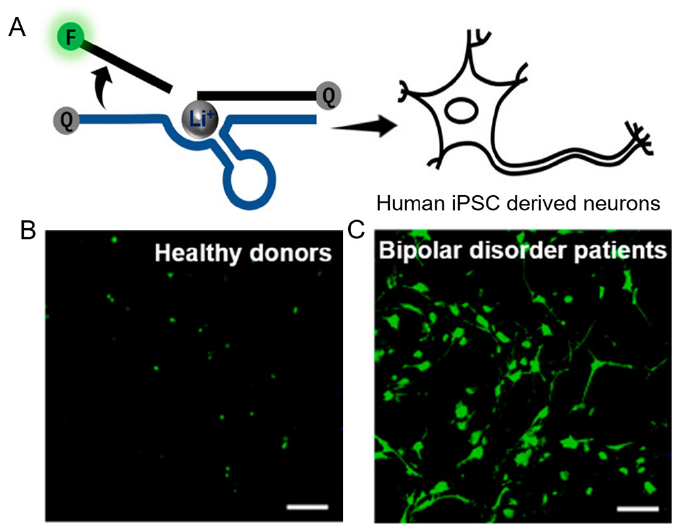
Figure 8. ( A ) Design of the Li + DNAzyme catalytic beacon. Intracellular Li + imaging in neural progenitor cells of ( B ) healthy donors; and ( C ) bipolar disorder patients. Reproduced from [134] with permission from the American Chemical Society, copyright